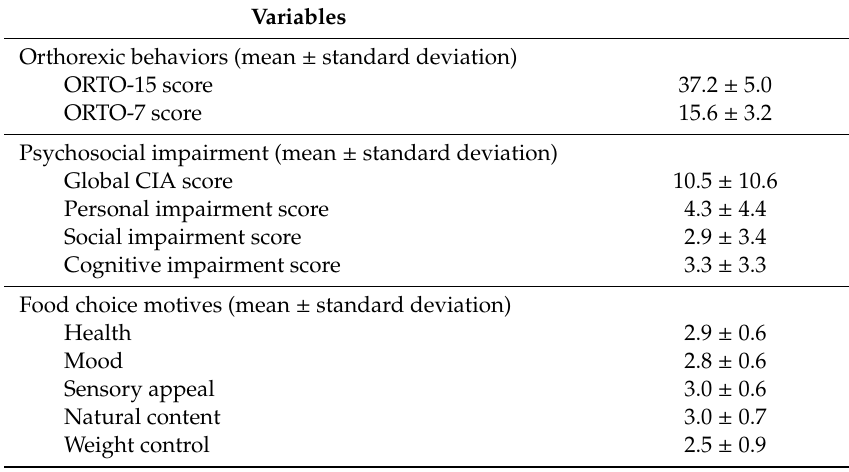
Table 3. Characteristics of the study sample including orthorexic behaviors, psychosocial impairment, and food choice motives ( N =